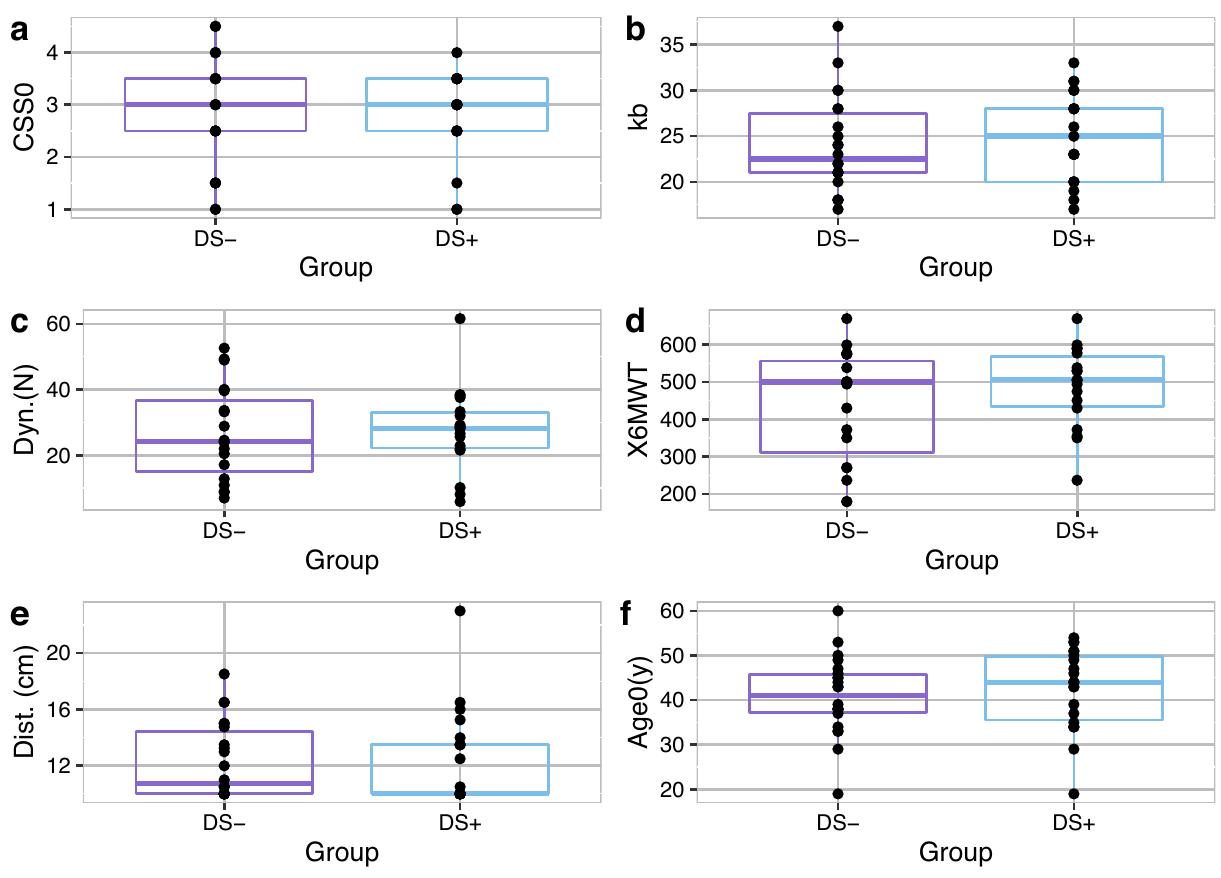
Figure 6. Functional results for the two patient groups FSHD-Δs+ /FSHD-Δs−: (a) Clinical Severity score at baseline (CSS0), (b) length of the 4q35 BlnI resistant, p13-E11 EcoRI fragment (kb), (c) dynamometric evaluation (N), (d) 6 min walking test. In addition, the distance between the 2 electrodes (e) and the age at baseline (f) are given for the two groups. FSHD-Δs+/FSHD-Δs− : groups of the strain data of FSHD patients based on the changes between t0 and t1.